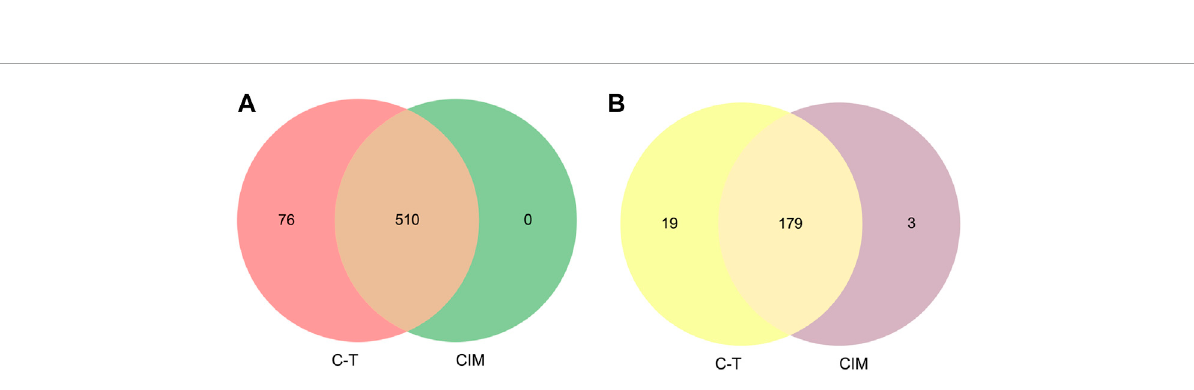
FIGURE 4 VenndiagramshowstheoverlapnumberofpathogenicgenesbetweentheC-TnetworkandCIM (A) .Functionalsimilarityanalysisbetweenthe C-T network and CIM (B) . CIM, key core function motifs; C-T, component – target.